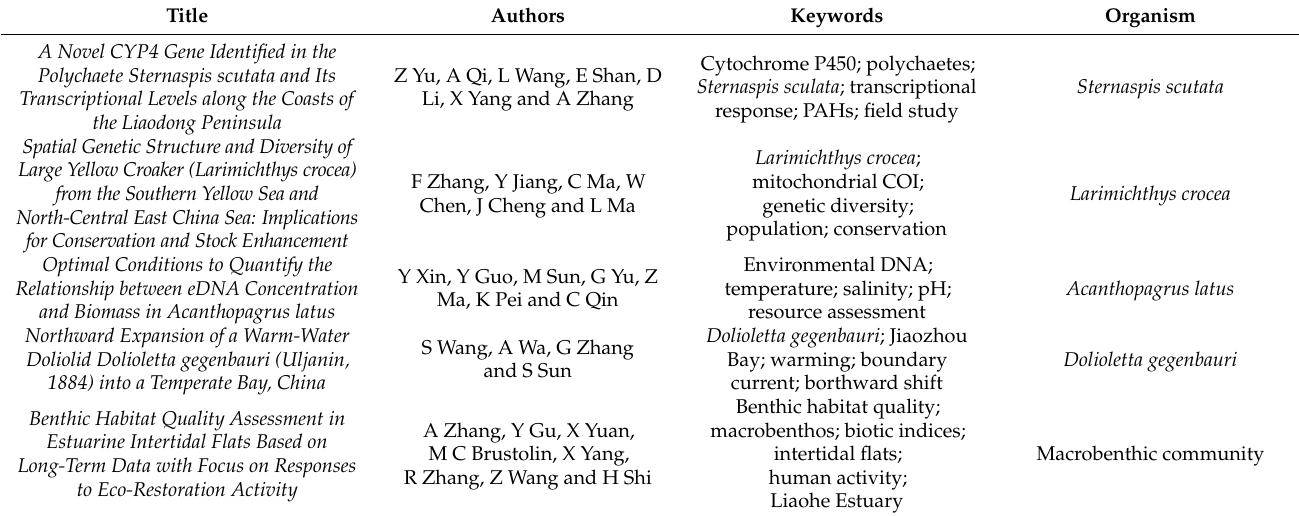
Table 1. Summary of the five papers published in this Special Issue, “Responses of Marine Life to Human Activity and Environmental Stress”, published in the journal Water